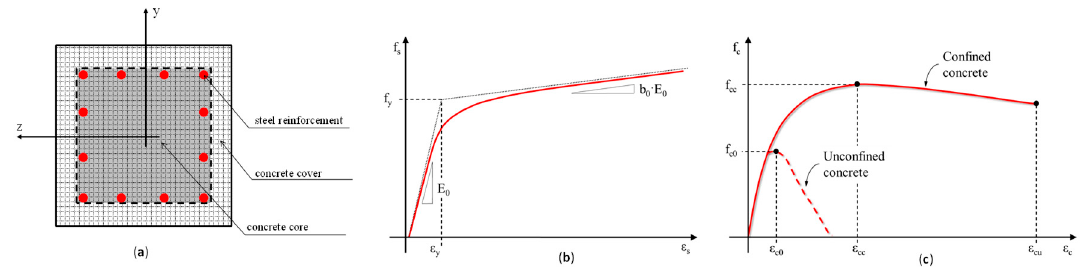
Figure 3. Properties of a RC section: ( a ) Fiber discretization of the section (y and z are the element local axis); ( b ) steel reinforcement and ( c ) cover (unconfined) and core (confined) concrete constitutive law (the meaning of the symbols is given in the text).